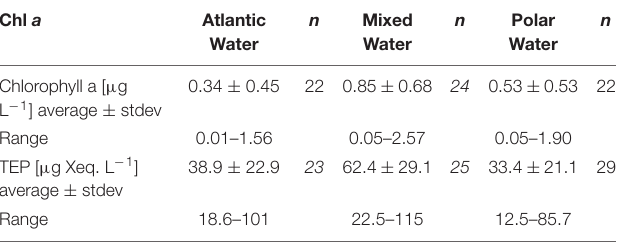
TABLE 2 | Chlorophyll a and TEP distribution across the different water masses.